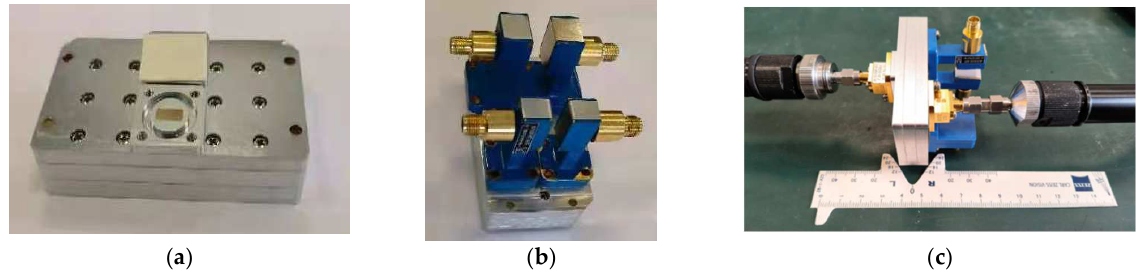
Figure 10. Fabricated cavity for the transmission model with the input port at the front ( a ); the output ports at the back ( b ); the dimensions ( c ).